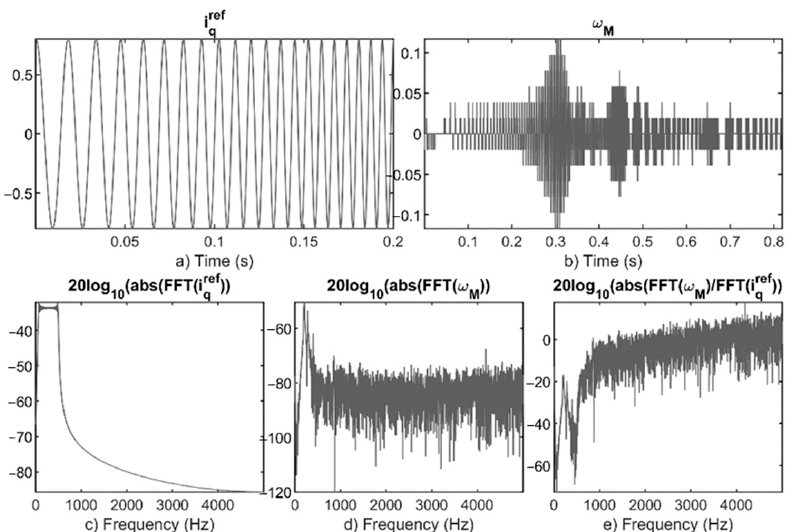
Figure 3. Data from the excitation procedure of direct drive. In the time domain: ( a ) excitation signal (input signal), ( b ) measured position (output signal); in the frequency domain: ( c ) amplitude spectrum of input, ( d ) amplitude spectrum of output, ( e ) frequency response data of direct